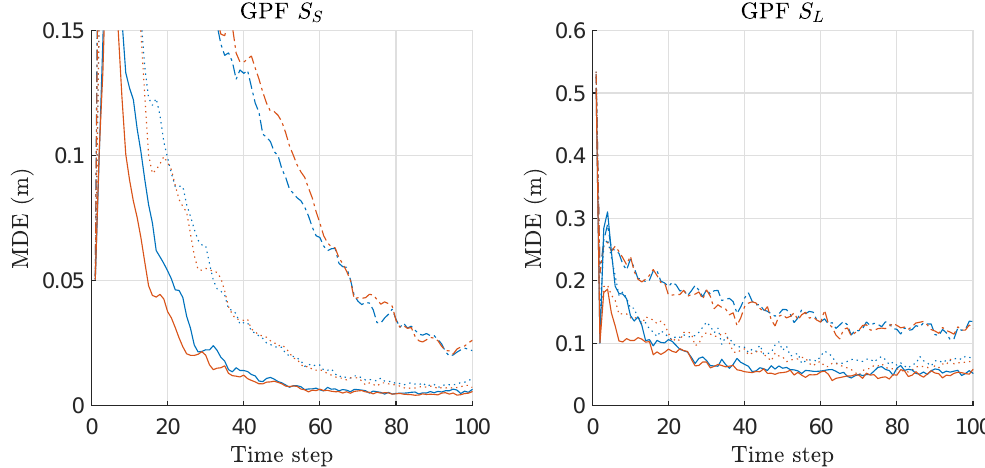
Figure 13. Mean distance error (MDE) performance comparison between Gaussian-PF (GPF) and minimax GPF (MGPF). Three hundred runs were performed with 1000 particles, where M , S S , S L denote the number of sensors, the scenario of the small state noise variance, the scenario of the large state noise variance, respectively. Legend: line style (dash-dot: M = 2; dotted: M = 5; solid: M = 10); (line color: blue: GPF; red: